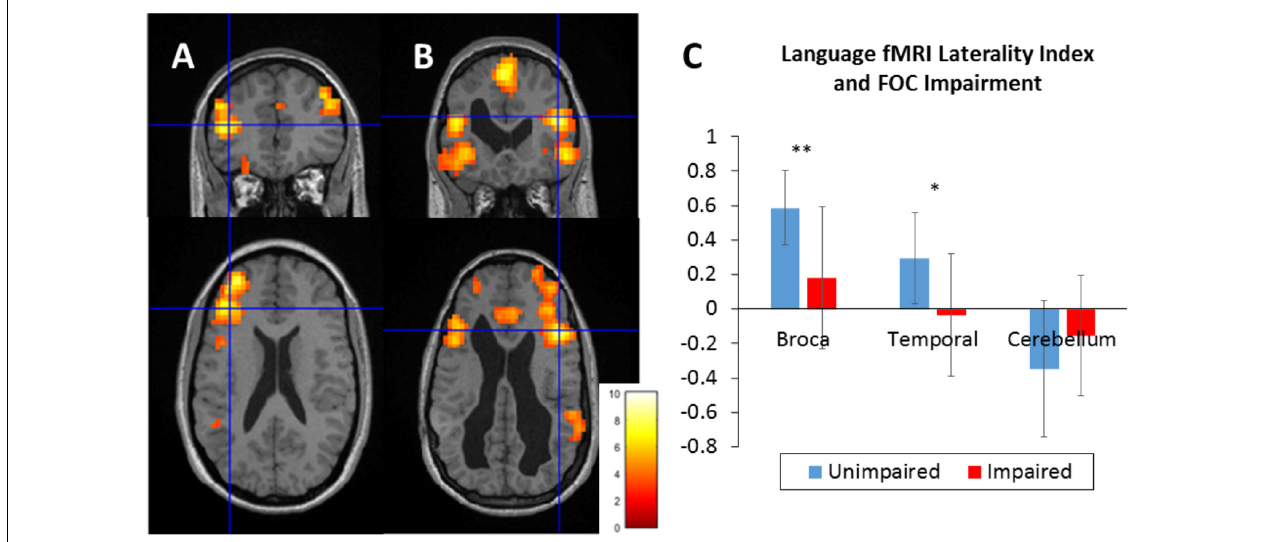
FIGURE 2 | fMRI language laterality in two example cases (A) – without oromotor impairment, (B) – with oromotor impairment, and (C) mean laterality indices in focal oromotor impairment groups. Both cases had sustained major preterm birth-related brain injury (still visible as enlargements of the lateral ventricles). Maps represent single subject activation during a verb generation task (thresholded at p < 0.001, color bar shows z -values). Left hemisphere is displayed on the left. Crosshair indicates inferior frontal activation peak. In case (A) with bilateral hemorrhagic lesion in the frontal cortex (left < right) shows left lateralization (Broca’s laterality index = +0.6). In case (B) (slurred speech at 4 years, now resolved) with bilateral hemorrhagic lesion in the frontal cortex (left > right) language was represented bilaterally (laterality index = –0.1). (C) Group differences in laterality indices in regions of interest (Broca’s region, temporal lobe, and cerebellum). Error bars represent SD; statistical difference: ∗∗ p < 0.001, ∗ p <